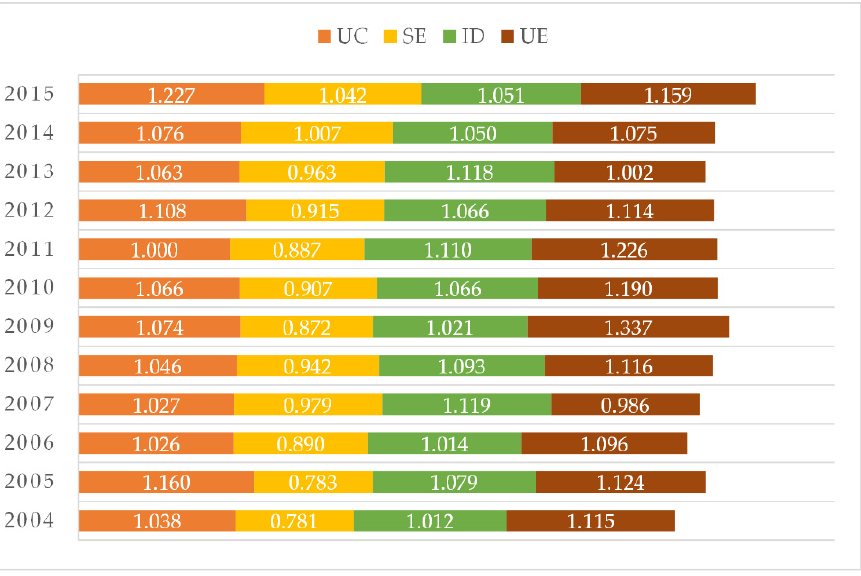
Figure 4. The four subsystems of the LCCC in the HCUA during 2004–2015.